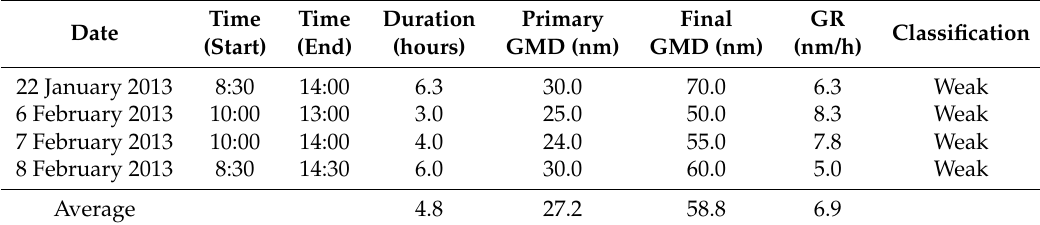
Table 1. Summary of the Class I particle formation event days during the MUMBA aerosol measurements period. GMD is the geometric mean diameter, and GR is growth rate as defined in Equation (1). The criteria for classification are discussed in Section